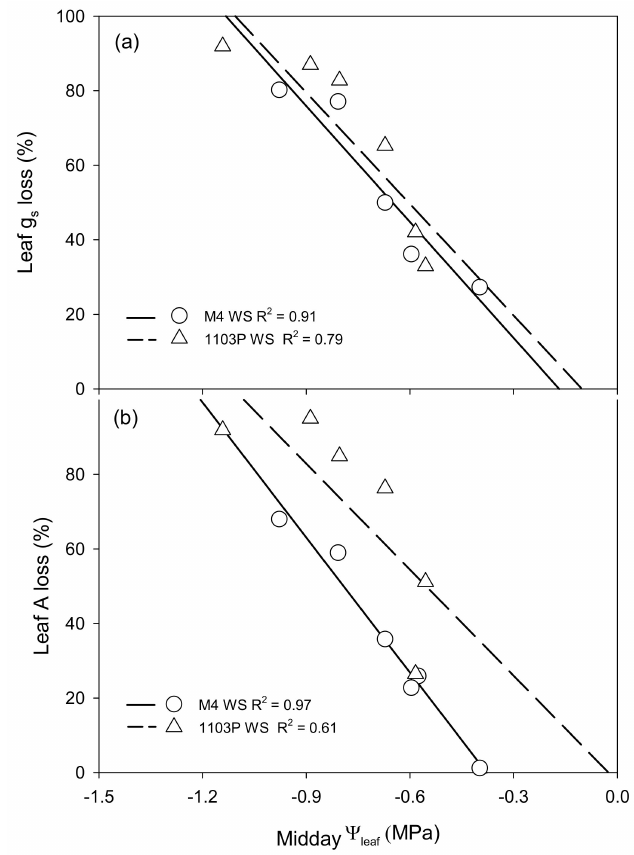
Figure 4. Panel ( a )—correlation between midday leaf water potential (Midday Ψ leaf ) and fraction of leaf stomatal conductance loss (Leaf g s loss). Panel ( b )—correlation between Midday Ψ leaf and fraction of leaf assimilation rate loss (Leaf A loss). M4-WS = water-stressed vines grafted to M4 (panel a: y = − 103.66x − 17.41, R 2 = 0.91, p < 0.05; panel b: y = − 120.76x − 45.61, R 2 = 0.97, p < 0.05); 1103P-WS = water-stressed vines grafted to 1103P (panel a: y = − 99.66x − 10.16, R 2 = 0.79, p < 0.05; panel b: y = − 94.76x − 2.39, R 2 = 0.61, p < 0.05).